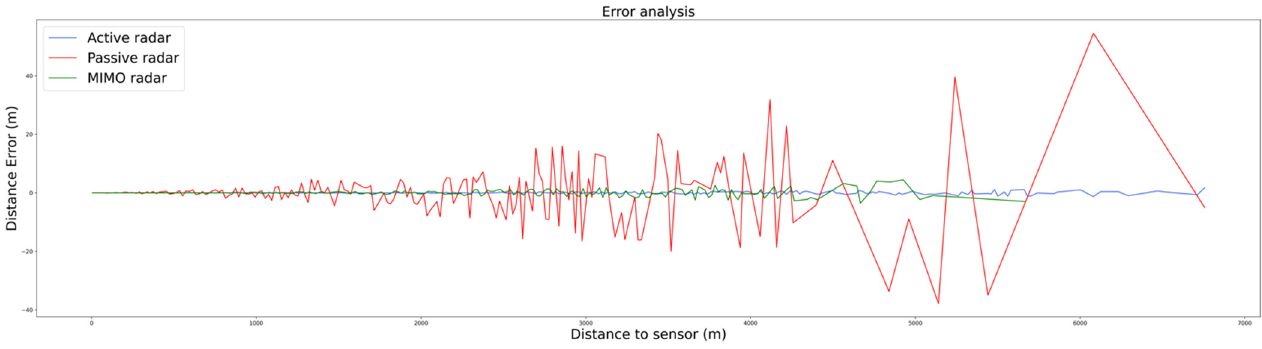
Figure 8. Distance error of each of the plots as distance to each of sensors’ receivers increases.